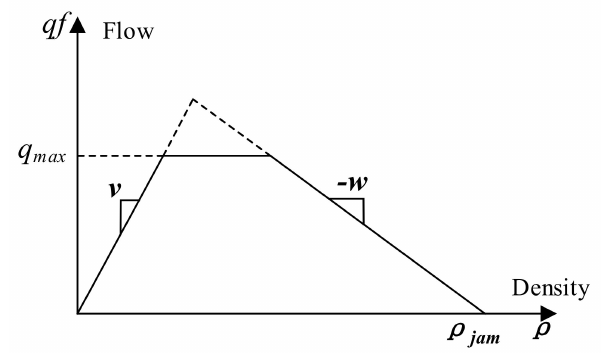
Figure 2. Density-flow relationship of the traffic